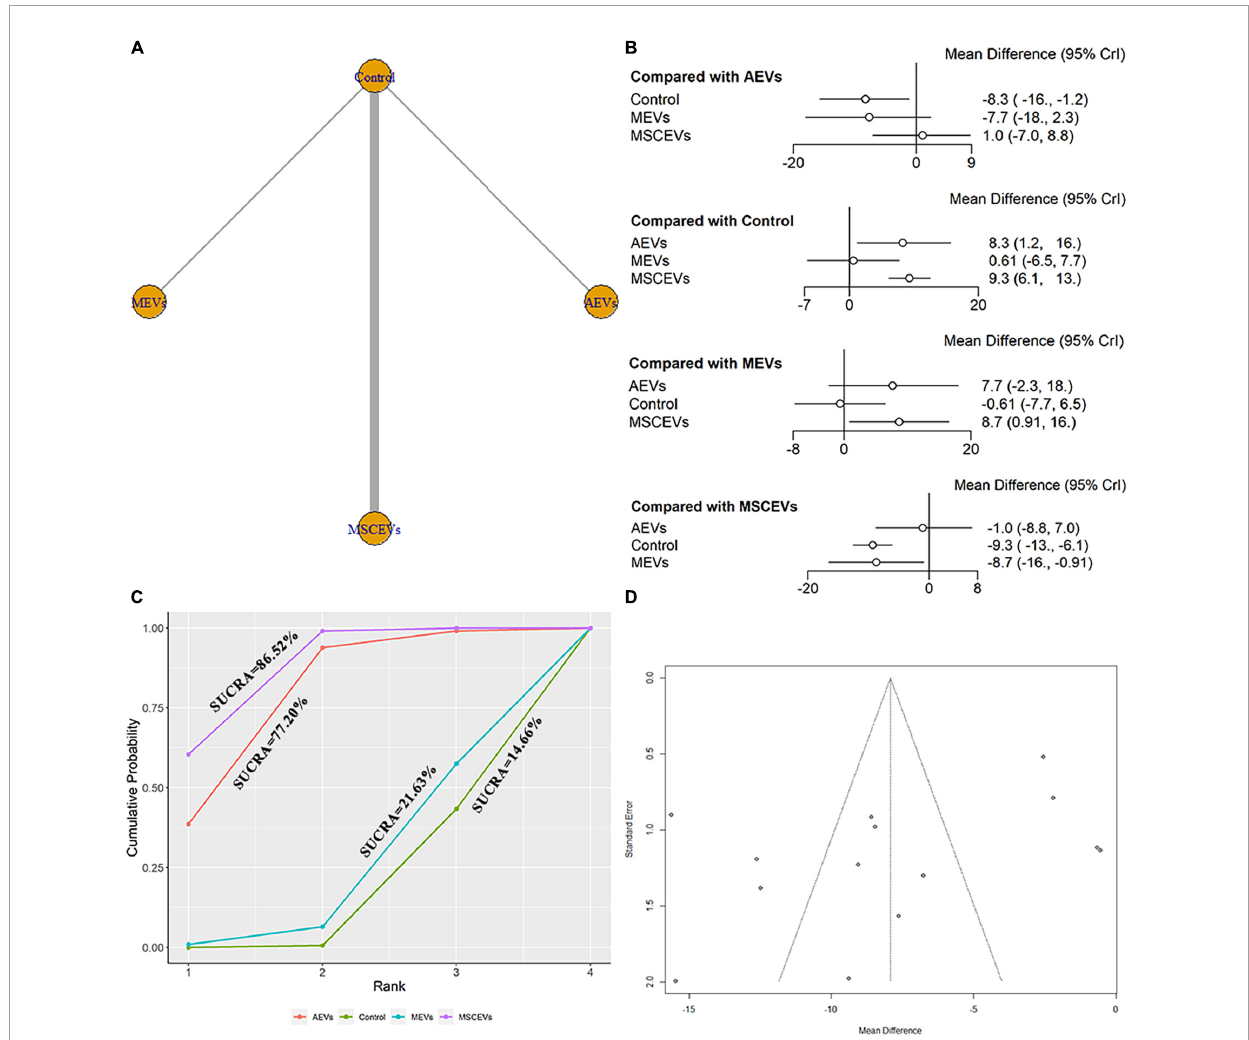
FIGURE9 Comparison of the efficacy of extracellular vesicles (EVs) from different cell sources in time spent in the goal quadrant in Morris Water Maze (MWM). (A) Network plot; (B) Forest plot; (C) Surface under the cumulative ranking curves (SUCRA); (D) Funnel plot. The dotted lines represent 95% confidence interval (95% CI). AEVs, astrocyte-derived extracellular vesicles; MEVs, microglia-derived extracellular vesicles; MSCEVs, mesenchymal stem cell-derived extracellular vesicles; NSCEVs, neural stem cell-derived extracellular